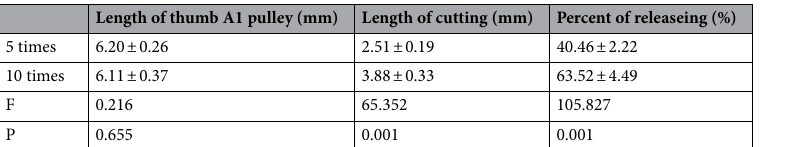
Table 2. The Rate of releaseing Thumb A1